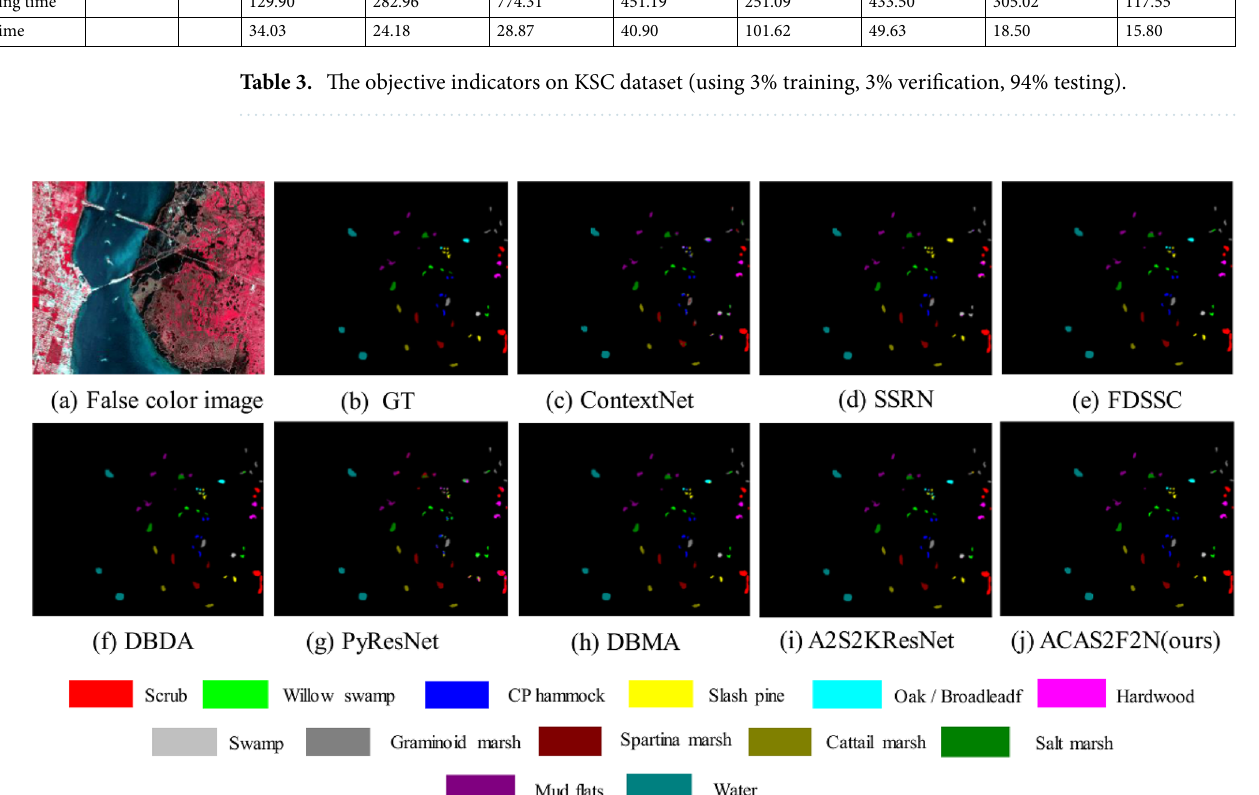
classification results. A2S2KResNet was proposed and published in TGRS2020. The OA, AA, Kappa, training time and test time of A2S2KResNet are 91.62, 93.37, 0.9091, 47.53, and 8.92, respectively. The OA, AA, Kappa, training time, and test time of the proposed ACAS2F2N are 94.63, 95.72, 0.9418, 50.29, and 7.09, respectively.